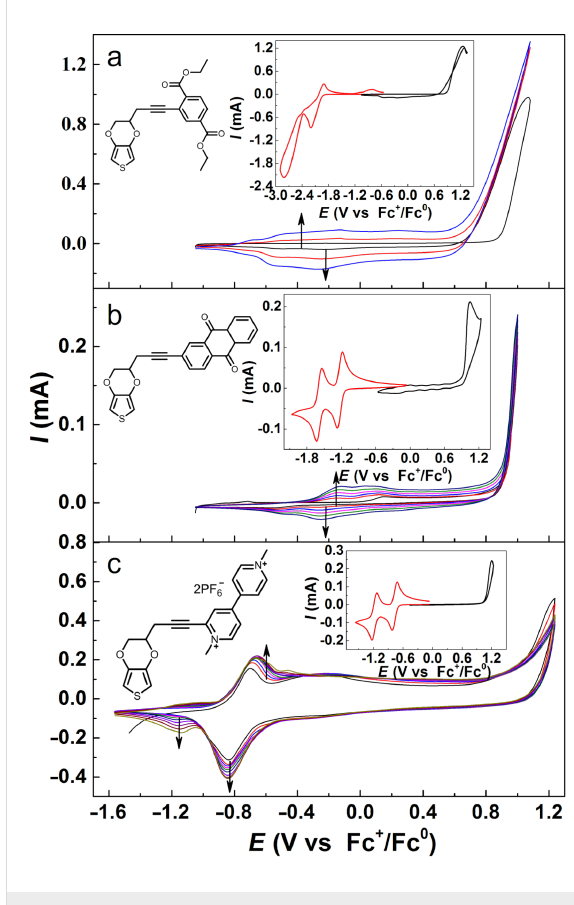
Figure 2: CVs of electrochemical polymerization of (a) pyEDOT-DeT ( 9 ), (b) pyEDOT-AQ ( 12 ) and (c) pyEDOT-MVPF6 ( 11 ) in MeCN with 0.1 M TEAPF 6 , GC, 0.1 V s − 1 . Insets show the structure and voltam- mograms for the monomers. Polymerization of pyEDOT-MVPF 6 was performed on a PEDOT-modified GC